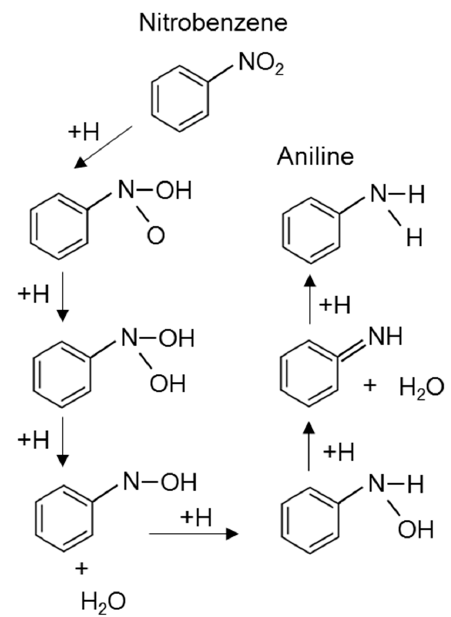
Figure 2. Surface reaction path of nitrobenzene hydrogenation to aniline on the bimetallic catalyst of platinum and palladium (mechanism B of Zhang et al. [24]). Table 1. Surface reaction mechanism for hydrogenation of nitrobenzene on palladium catalyst. Species adsorbed on the surface are indicated by suffix (s). For reactions R11, R13, R15, R17 and R19, the activation energy E a, j dependsoncoverage( θ i )duetothelateralinteractionbetweentheadsorbedspecies. Theunits of the pre-exponential factors A j (as well as of k j in Equation (12)) vary depending on the exponent of the concentration multiplied to the rate constant and are a combination of cm, mol, and